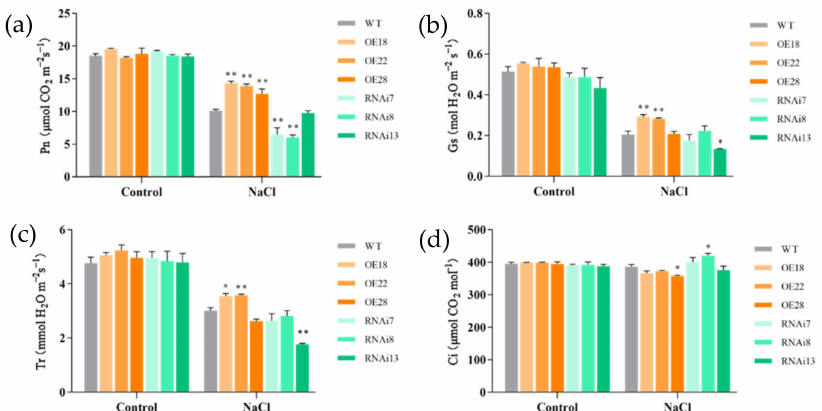
Figure 4. Effects of NaCl treatment on the photosynthetic characteristics of wild-type (WT), over- expression (OE18, OE22, and OE28), and RNAi lines (RNAi7, RNAi8, and RNAi13). ( a ) Net pho- tosynthetic rate (Pn), ( b ) stomatal conductance (Gs), ( c ) intercellular CO 2 concentration (Ci), and ( d ) transpiration rate (Tr) were measured after 6 d of NaCl treatment. The experiment was repeated three times, and each treatment included four replications. Data are means ± SE ( n = 4). An as- terisk indicates a significant difference (LSD test, * p < 0.05 and ** p < 0.01) between wild-type, overexpression, and RNAi